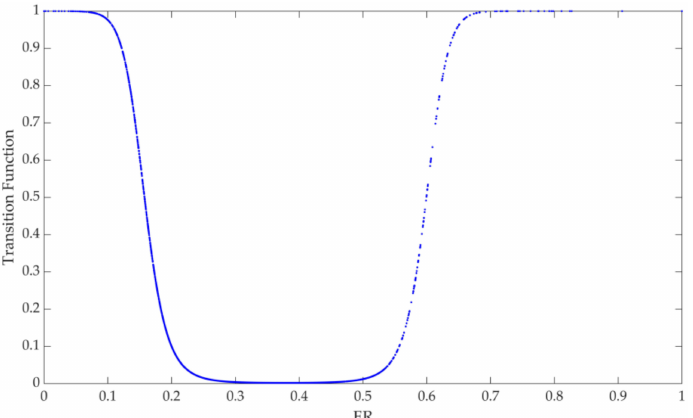
Figure 2. Transition function figure of ER.